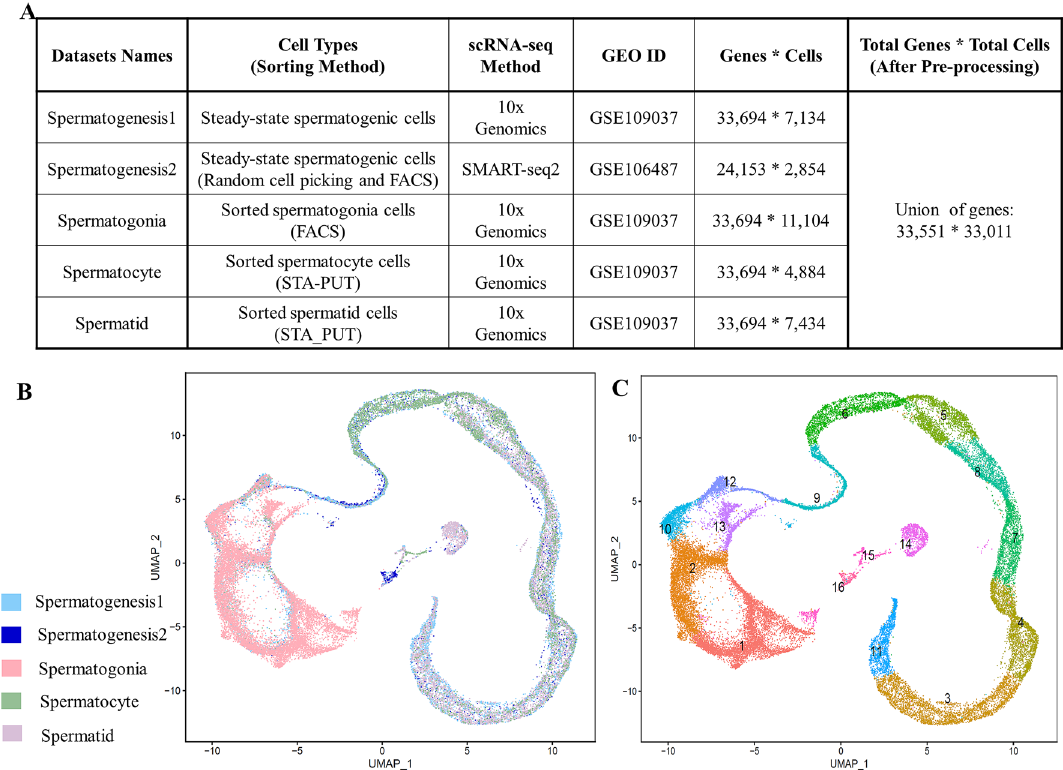
Figure 1. Profiling and integrating testicular datasets. ( A ) Datasets information of adult human testicular cells that were integrated and analyzed, such as sorting methods, scRNA-seq methods, GEO ID, and the number of genes and cells for each data set were listed. ( B , C ) UMAP plot of integrated human testicular cells. Cells are colored based on ( B ) the original datasets, ( C ) clustering